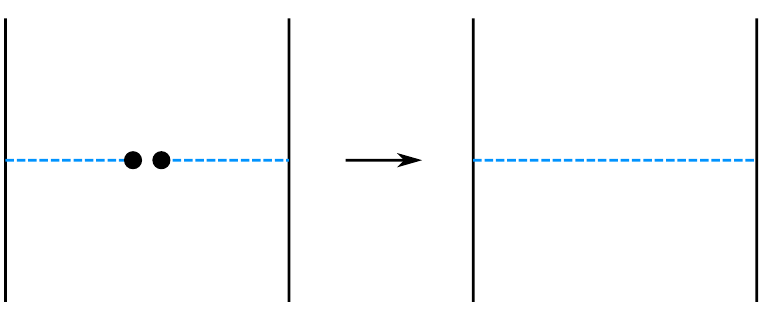
Figure 8 . Building a gauge or gravitational Wilson line by bringing together dressed matter